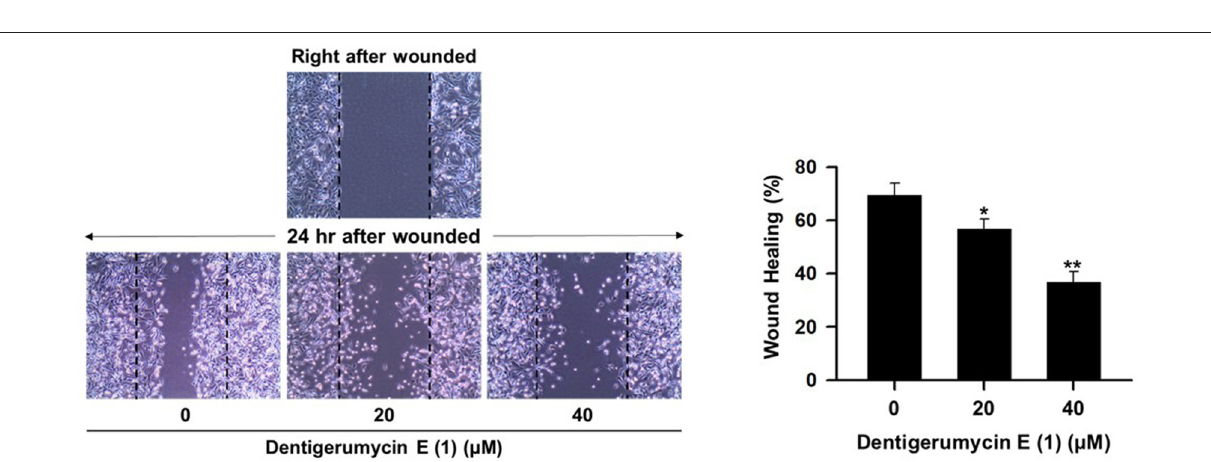
on the structure, the BGC was composed of a multimodular hybrid polyketide synthase (PKS) and a nonribosomal peptide synthetase (NRPS) ( Figure 5 ). The feature of NRPS involving six modules in the four open reading frames (ORFs 6590,